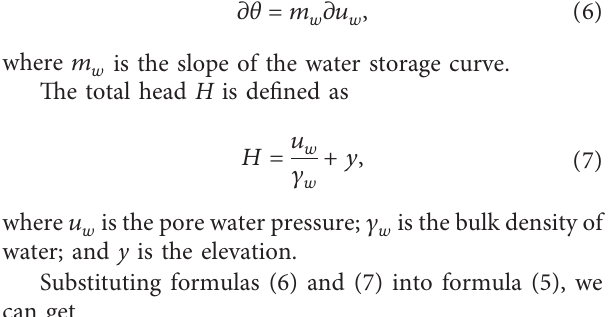
Figure 11: The average infiltration rate varies with the height of the particle